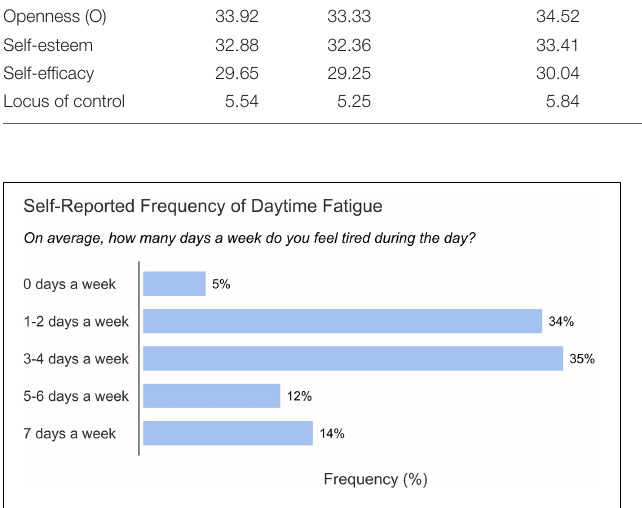
FIGURE 1 | Bar plot showing the distribution of responses to the question about the average frequency of experiencing daytime